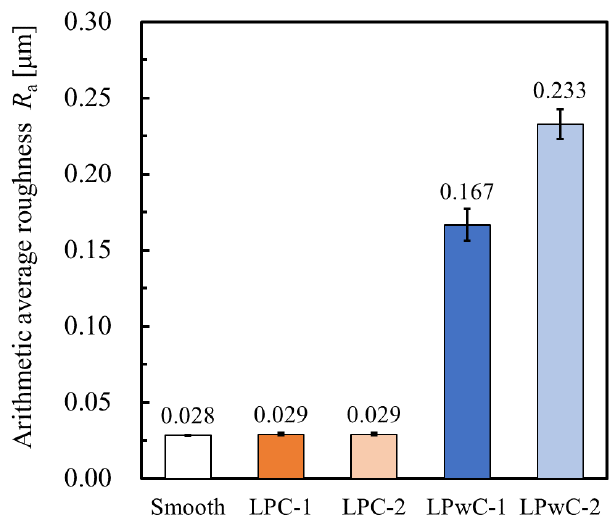
Figure 6. Comparison of surface roughness Ra of specimens.